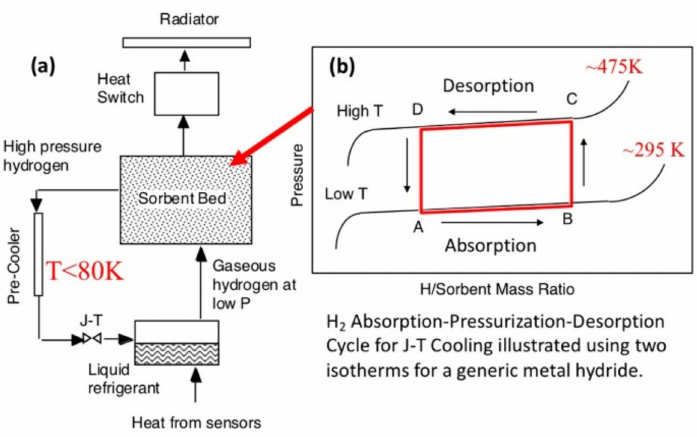
Figure 8. ( a ) Schematic diagram of a single-stage sorption cryocooler with a metal hydride sorbent bed producing liquid hydrogen and ( b ) the idealized closed-loop cycle A–B–C–D that is superim- posed on the isotherms for a representative metal hydride